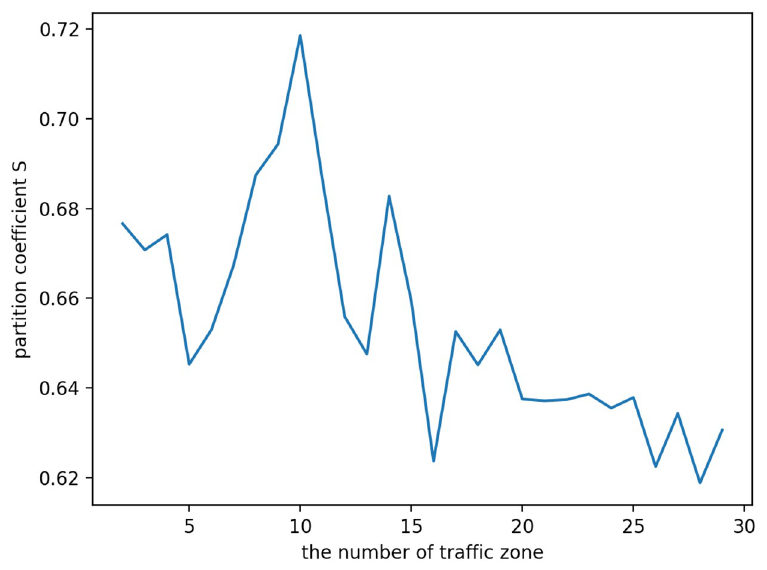
Fig 4. Curve of the BWP value variation with the k value.